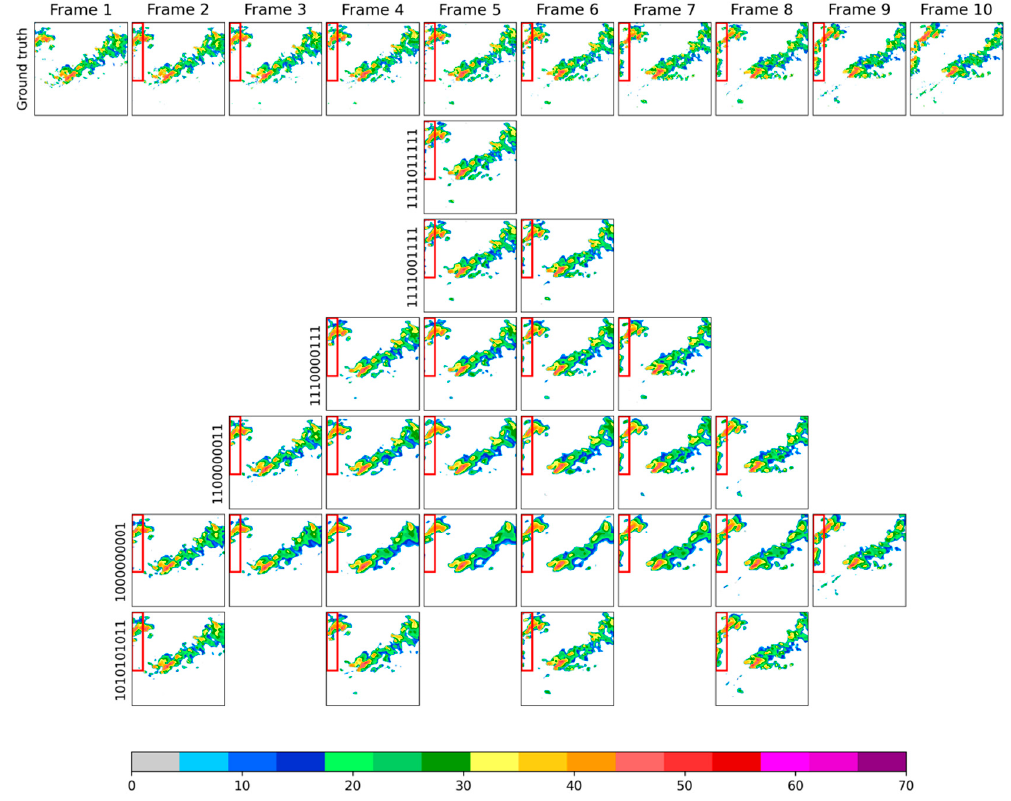
Figure 6. Example of reconstructing missing radar frames with the CNN-BiConvLSTM model. The first line shows the input radar images (ground truths); the second line to the seventh line show reconstructed radar images for 6 specified missing patterns.